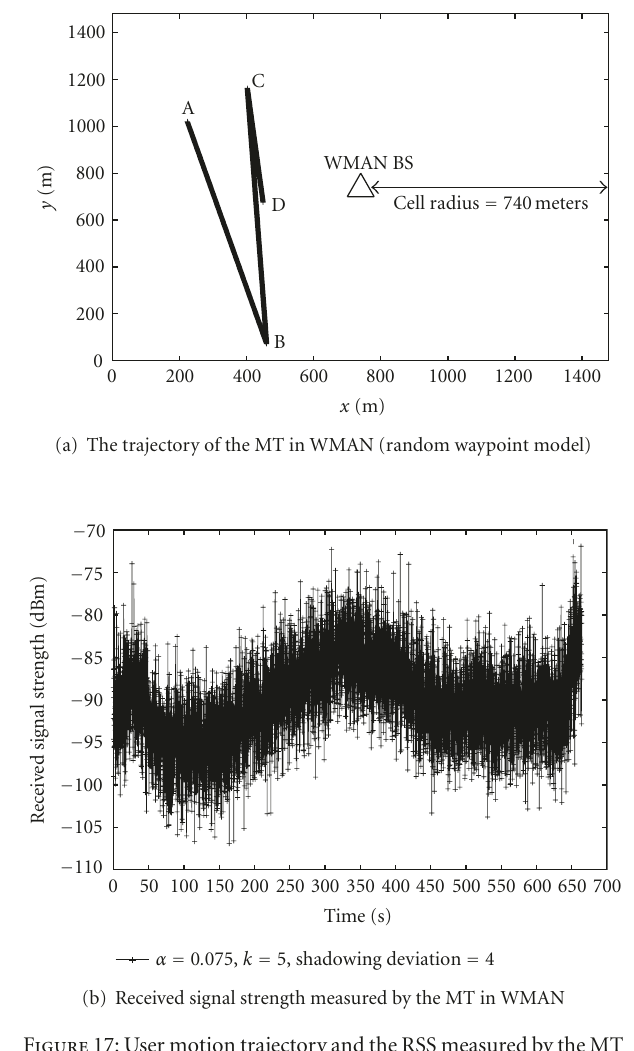
Figure 17: User motion trajectory and the RSS measured by the MT in WMAN.